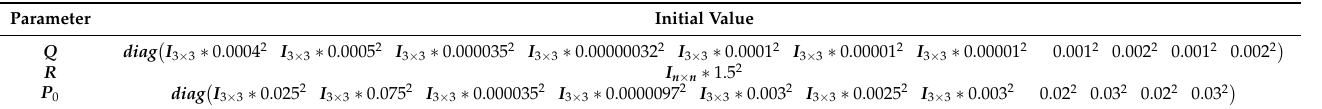
Table 1. The parameters used for the